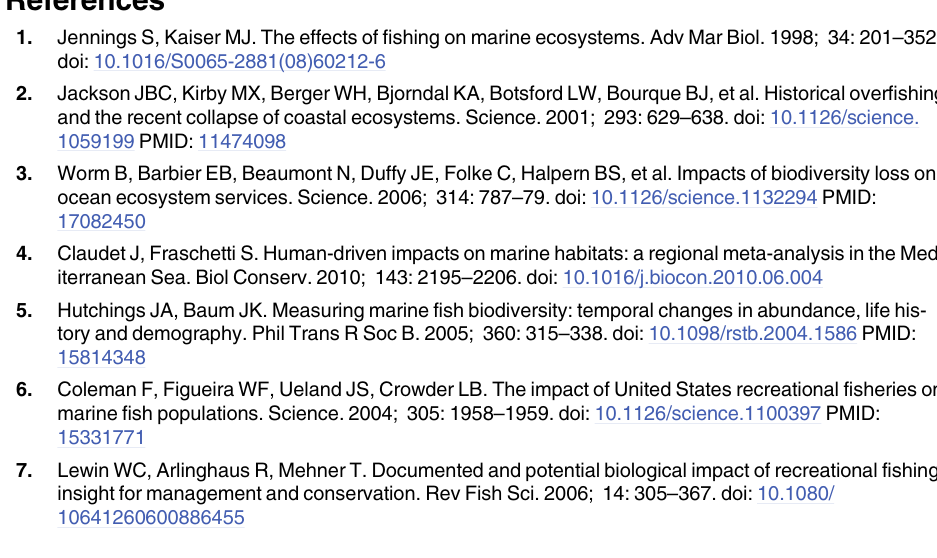
S2 Table. Complete results of multivariate Permanova analyses on square root transformed